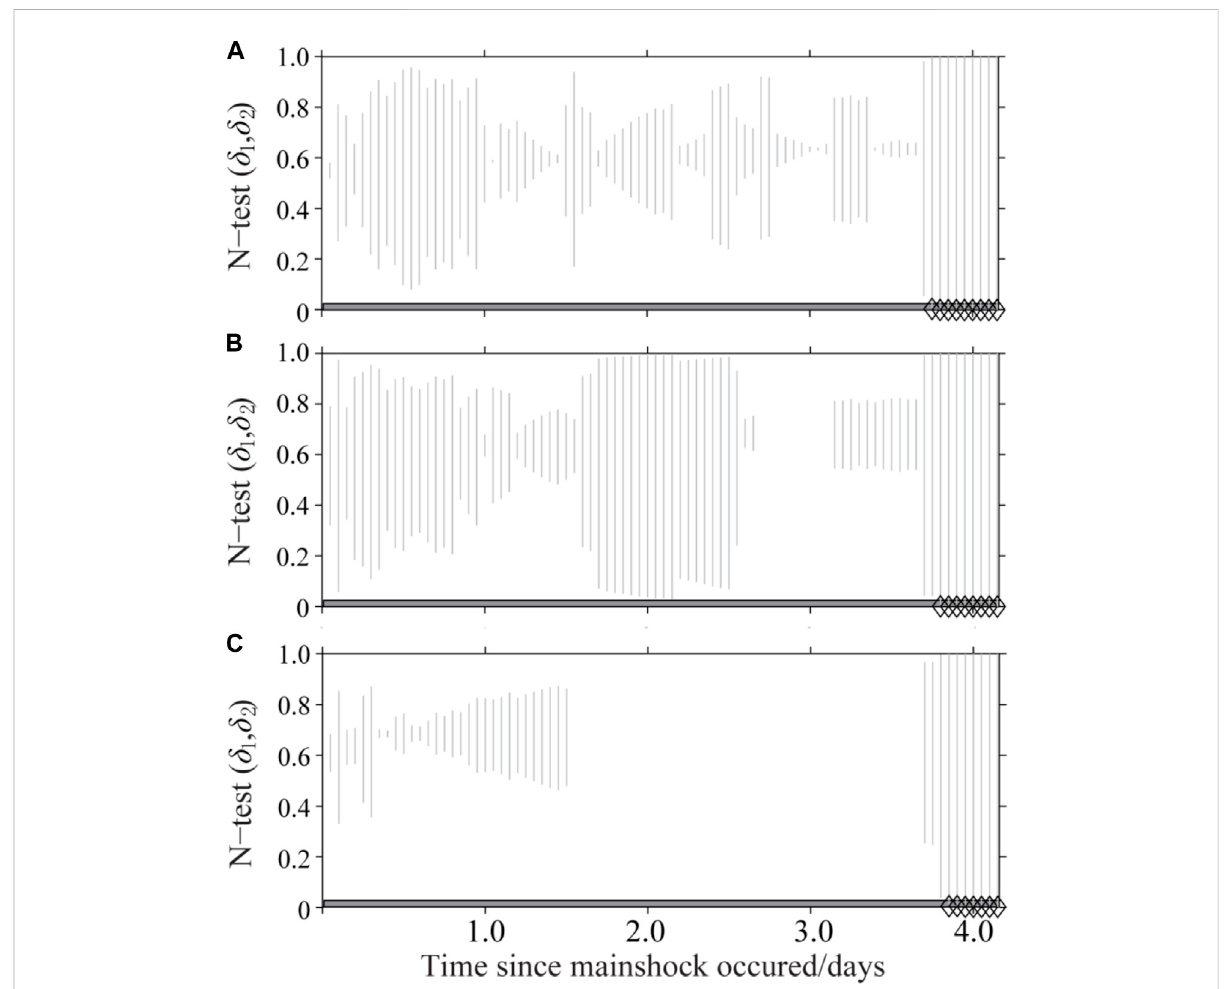
FIGURE 3 N-test results for future 1-day aftershock forecasting of the Menyuan M S 6.9 earthquake sequence. (A – C) Forecasting performance evaluation oftheOmi-R-Jmodelforthethreetargetmagnitudes,3.0,3.5,4.0,respectively.Theverticalgraydashedlinesconnectthe δ 1 and δ 2 values,whilethe blackdiamondsandbluesquaresshowtheresultswith δ 1 < 0.025and δ 2 < 0.025,respectively. Theblankareaindicatesthatnoeventofcorresponding magnitudes have occurred in the forecasting